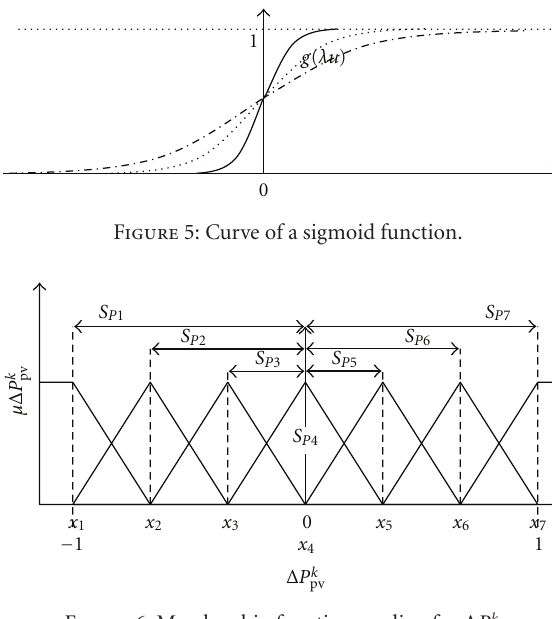
Figure 6: Membership functions coding for Δ P k